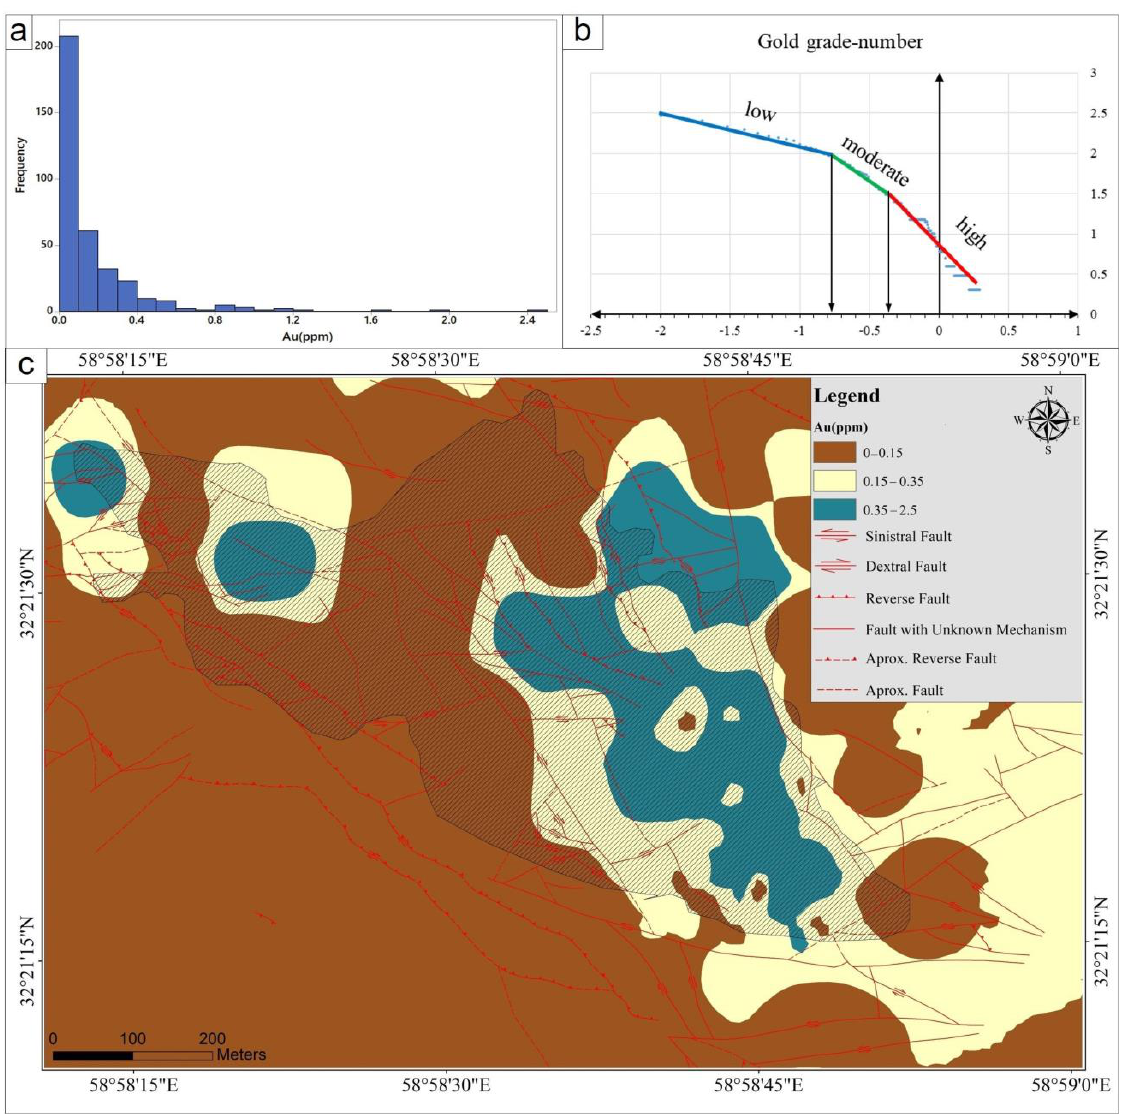
Figure 10. ( a ) Histograms of Au assay data, ( b ) C – N curve of Au assay data, ( c ) contoured Au geo- chemical assay population distribution (surface) map.